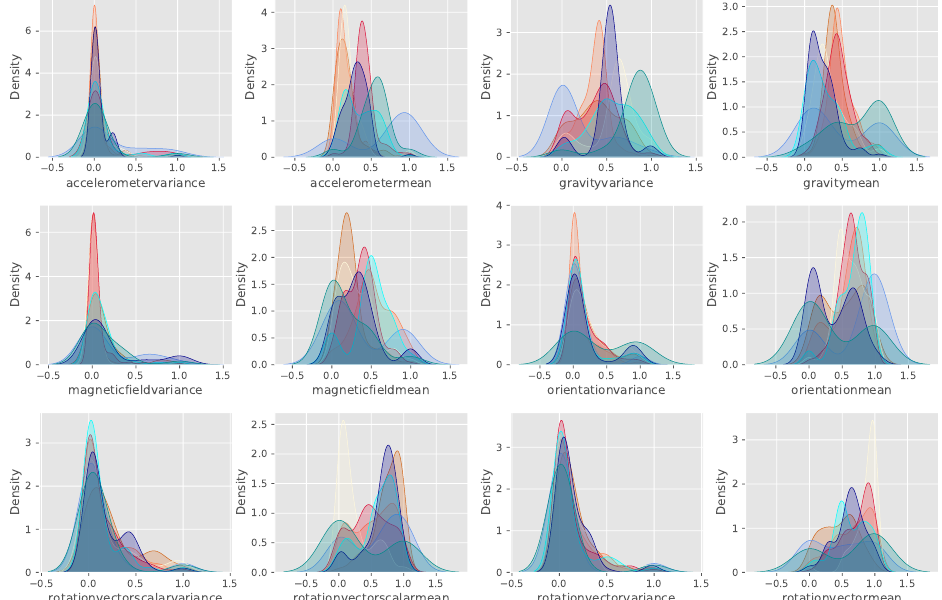
Figure 1. Distribution of each feature across individuals. Each figure refers to the distribution of a certain feature, and the curves in each subplot are the distribution of the feature estimated by the KDE of eight randomly selected